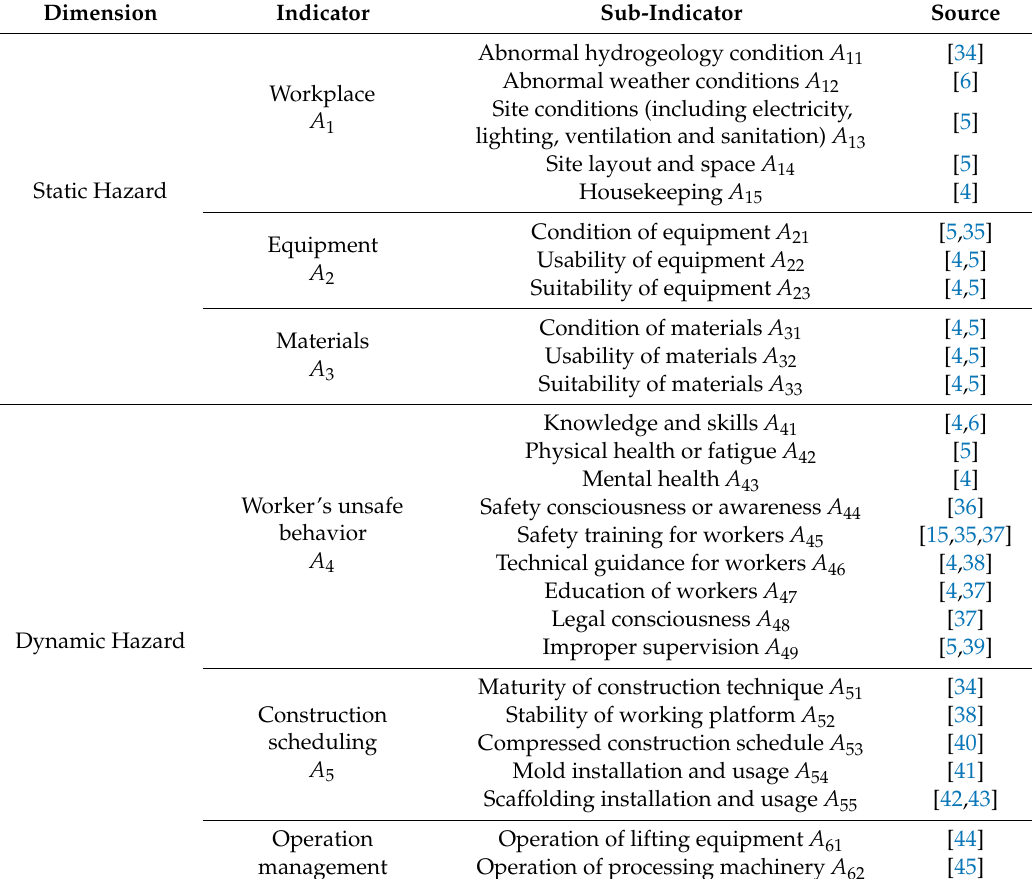
Table 1. Potential hazard indicators of construction safety